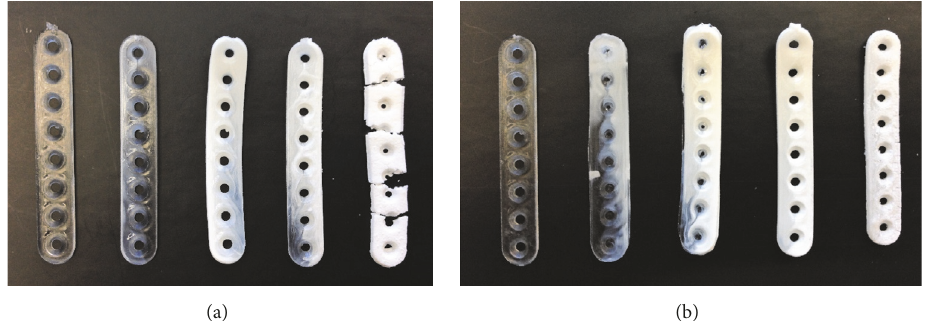
Figure 7: Visual appearance images of the degradation of the PLGA low T (a) and PLGA high T (b) plates at the different degradation points: 0, 15, 30, 60, and 120 days from left to right.